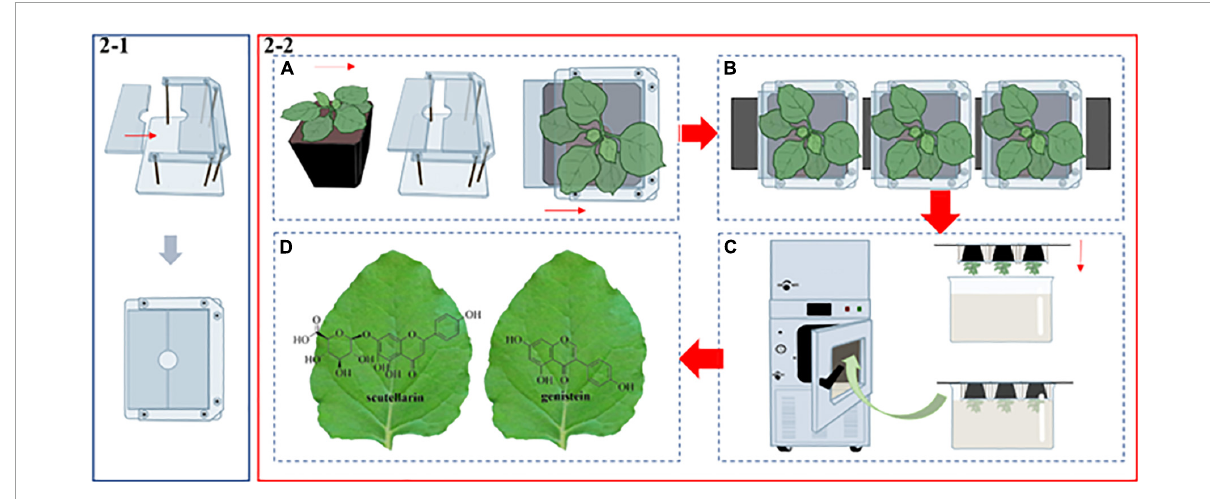
FIGURE2 A schematic diagram of the novel E-platform. (2–1) The structure of the transparent cube-mold. (2–2) Vacuum infiltration process. (A) The fabrication process of N . benthamiana . (B) The union of several N. benthamiana . (C) The leaves were inverted into a stainless steel-tank filled with A. tumefaciens suspension. Then, the tank was transferred to the vacuum infiltration device. (D) The infiltrated leaves contain two high-value